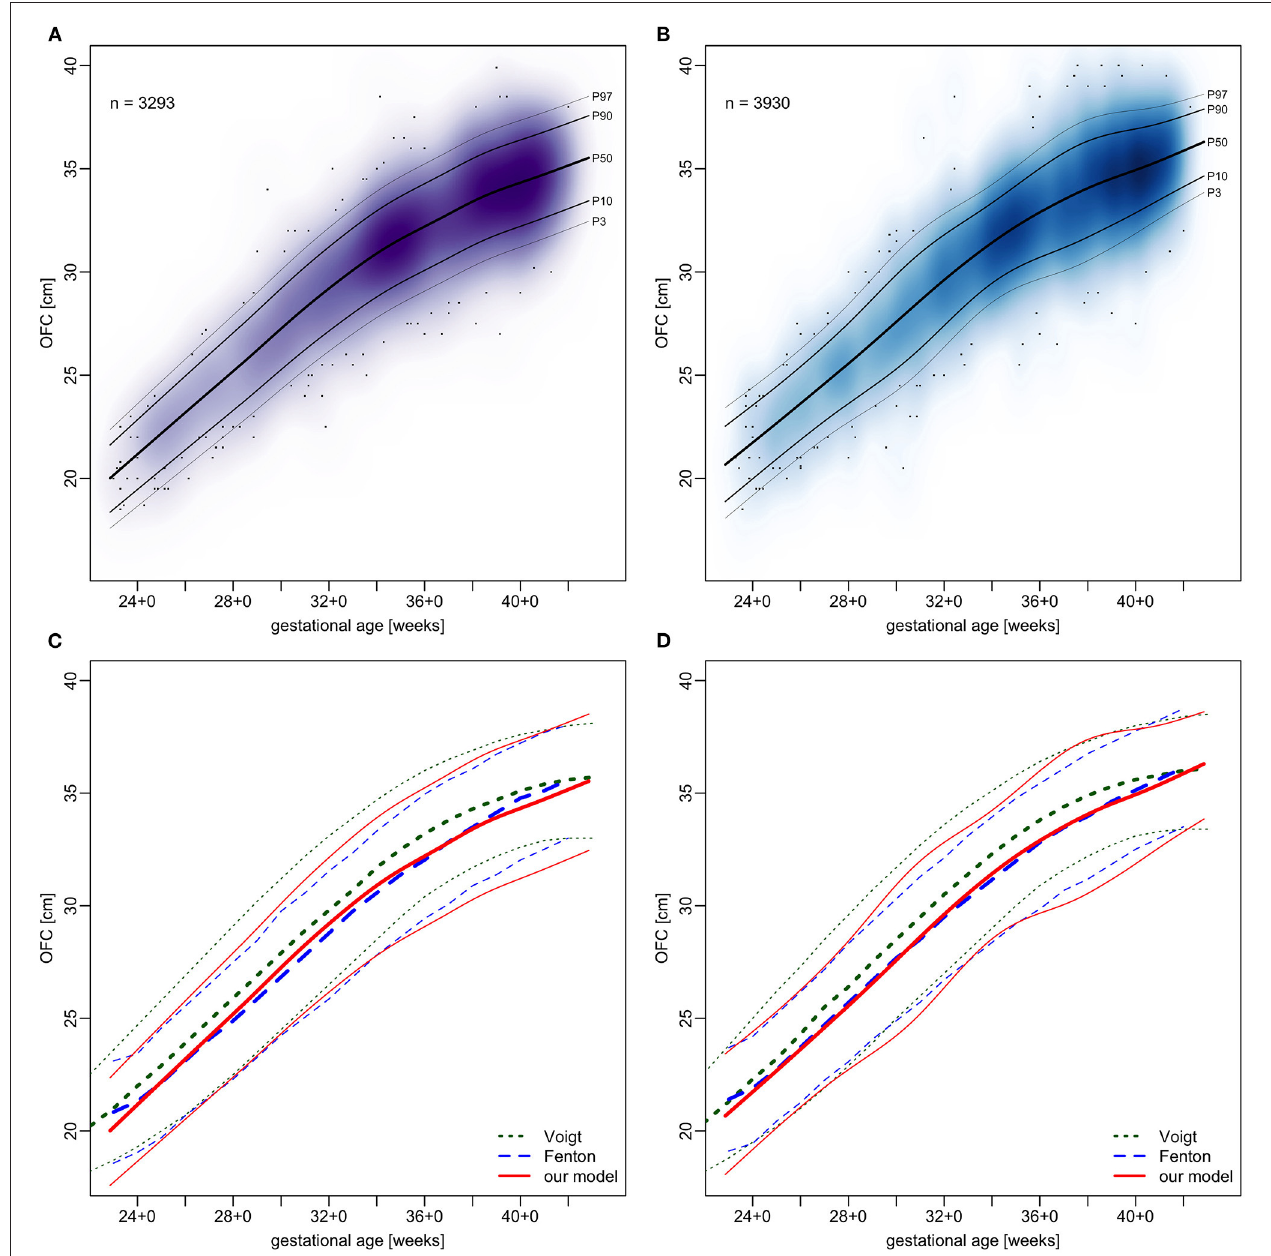
FIGURE 5 | Charts of occipitofrontal circumference (OFC) in relation to gestational age. (A,B) our sample with fitted models. (C , D) comparison of our models (red) with Voigt et al. (17) (green) and Fenton and Kim (13) (blue), shown are 3rd, 50th, and 97th percentiles. (A,C) girls and (B,D)